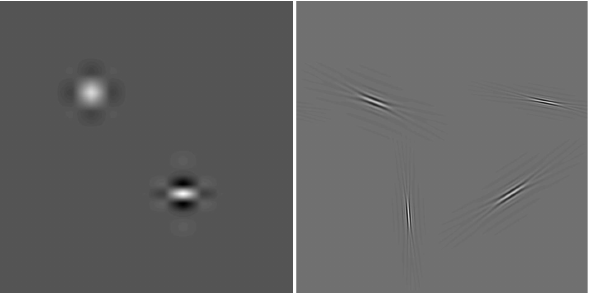
Figure 6. Support of atoms of multiscale decomposition: wavelet (left panel) and curvelet (right panel).